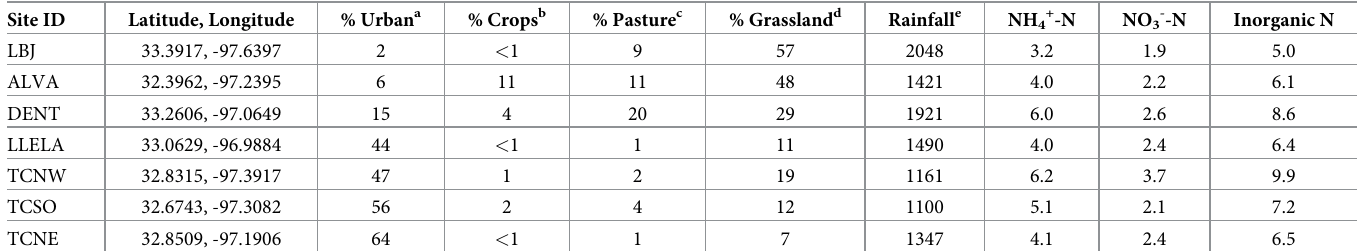
Table 1. Study site